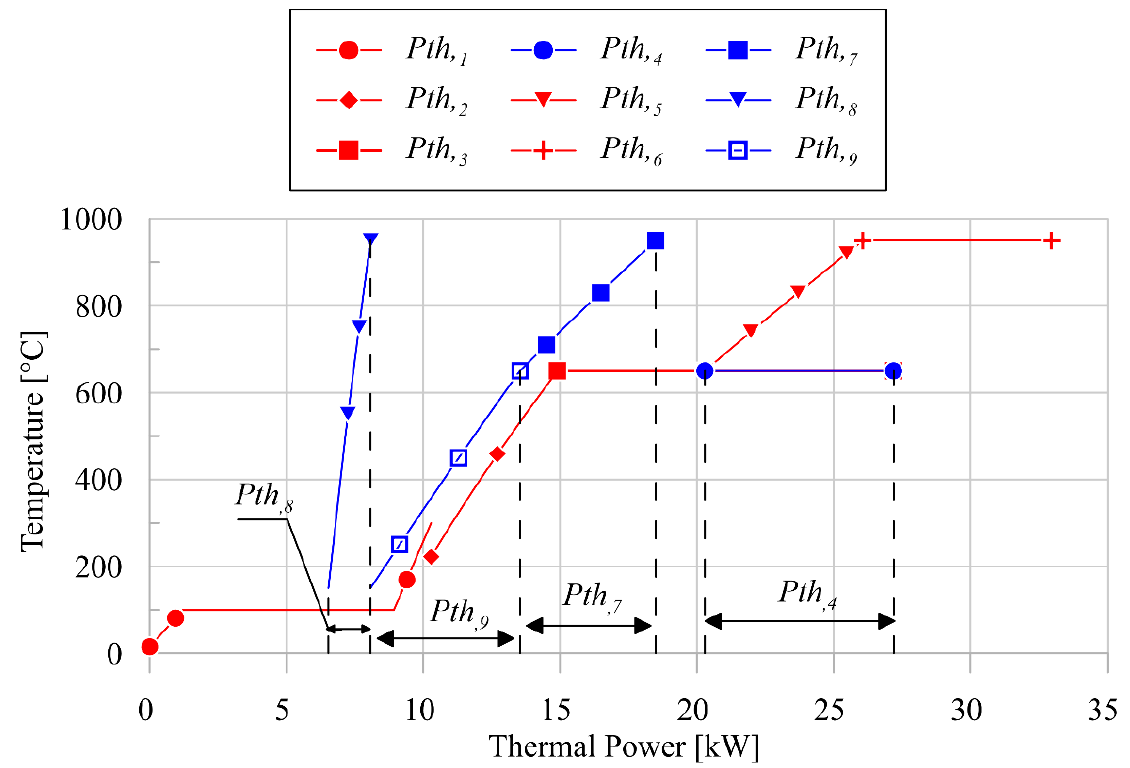
Figure 6. Temperature as a function of thermal power for different SESMR stages (red lines are the required powers, blue lines are the available powers).